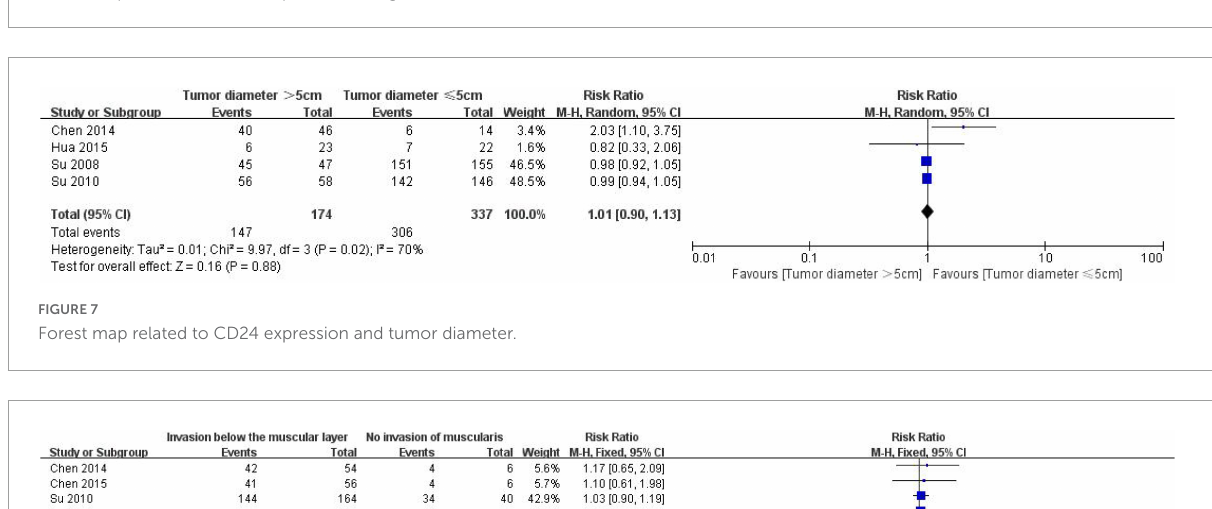
FIGURE6 Forest map related to CD24 expression and gender.